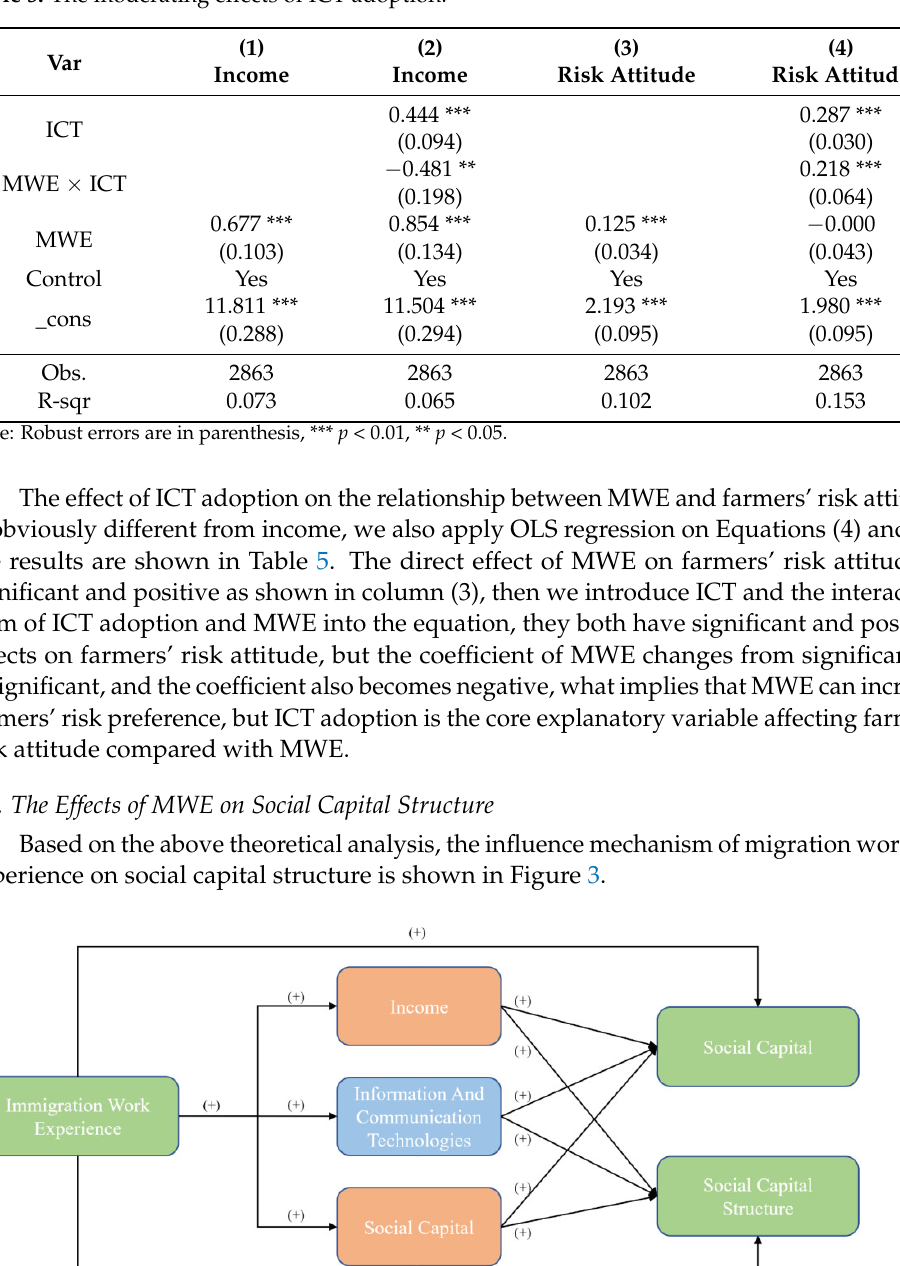
Table 6. Direct Effects and Mediating Effects on Weak ties in Social Capital.